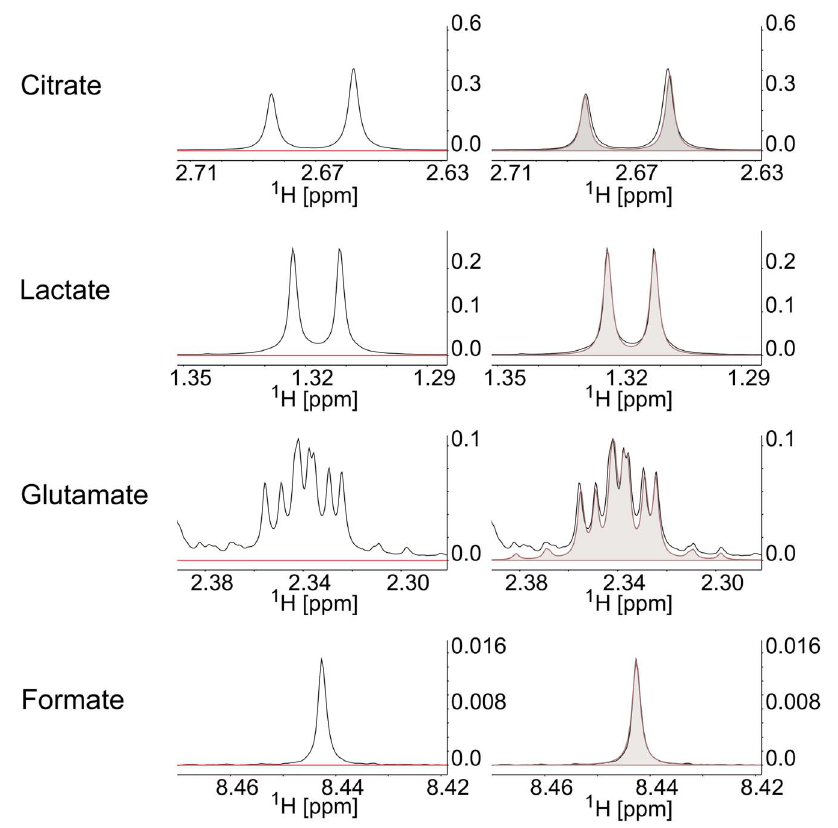
Fig. 1. Example metabolic quantification using Chenomx database. Localised spectral plots for metabolites of interest with shaded figures illustrating metabolite quantification via best fit analysis using Chenomx metabolite